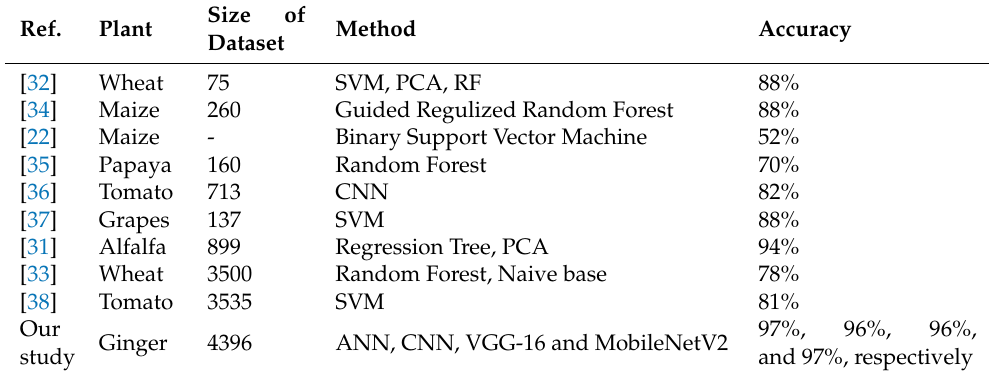
Table 12. Performance comparison of proposed work with other existing works.